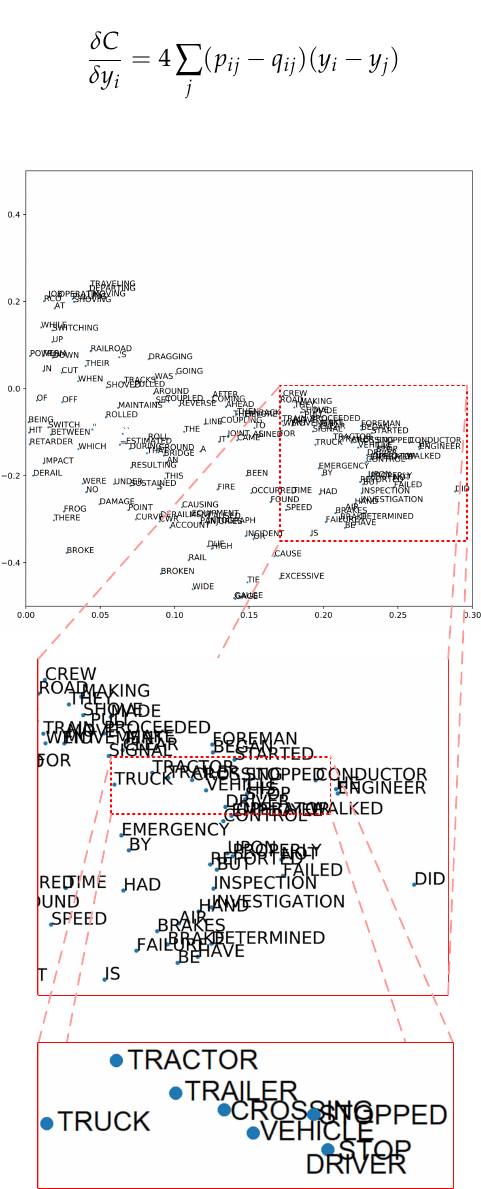
Figure 8. This figure presents the t-distributed stochastic neighbor embedding (t-SNE) visualization of Word2vec of the Federal Railroad Administration (FRA) data